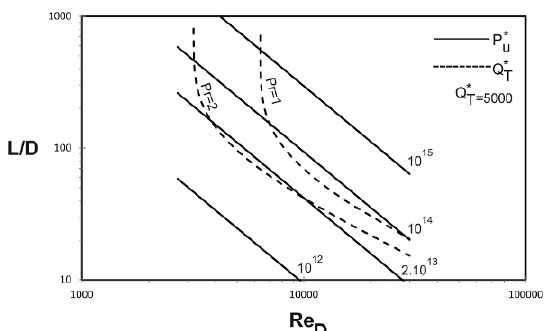
Figure 8. Influence of the Prandtl number on the variation of L/D group with the Reynolds number (turbulent regime and constant heat-flux boundary)